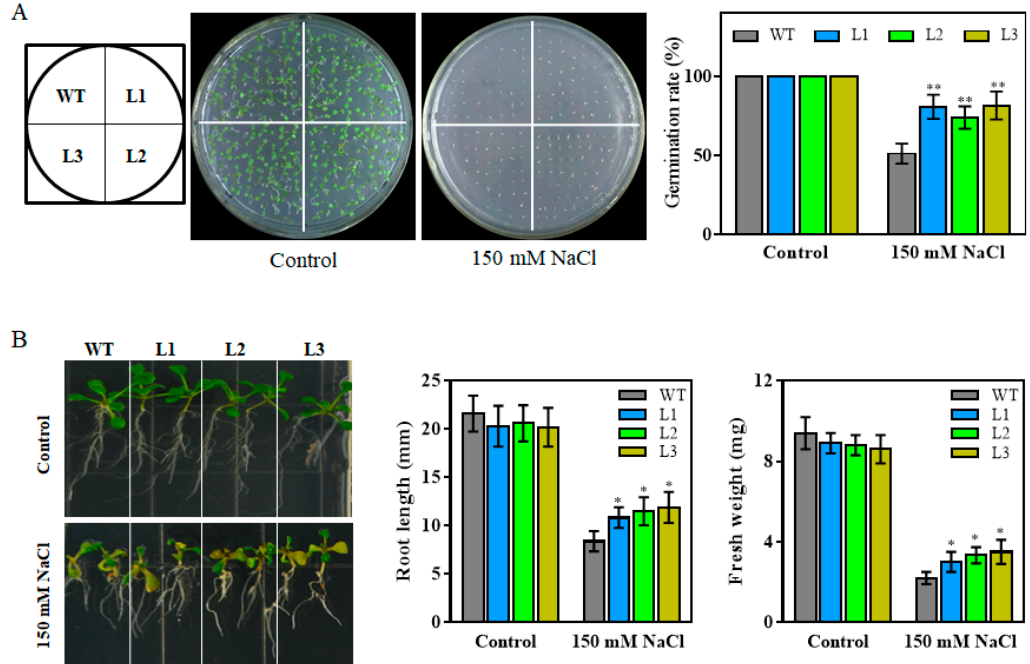
Figure 5. E ff ect of salt stress on WT and transgenic Arabidopsis plants. ( A ) Comparison of germination rates among WT and three transgenic lines (L1, L2, and L3) under salt stress (NaCl). Seeds were germinated on 1 / 2MS plates supplemented with 0 (control) or 150 mM NaCl. The data was recorded after four days of germination. ( B ) Growth and biomass accumulation of seven-day-old seedlings of WT and three transgenic lines treated with 150 mM NaCl for five days. Values are means ± SD from three independent measurements ( * p < 0.05, ** p < 0.01 by Student’s t